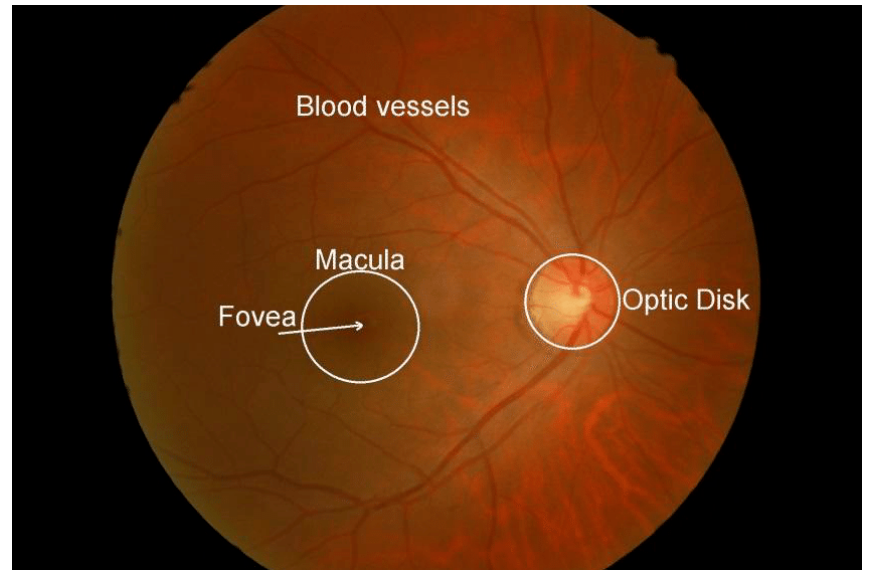
Figure 1. Anatomical structures on the retina.